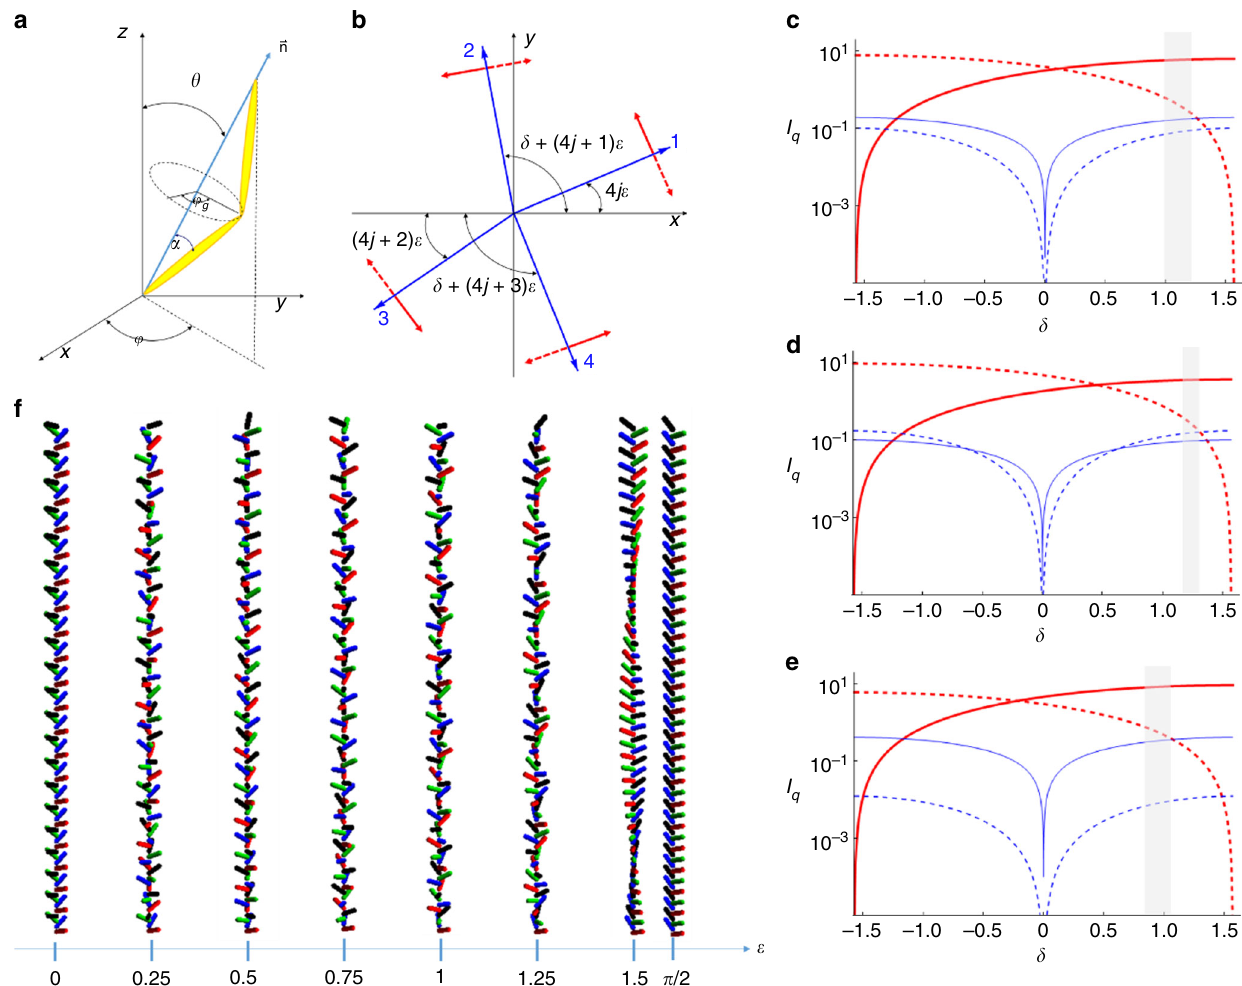
* ) in the laboratory frame is described by the tilt Fig. 3 The double-helical structure in material D1 . a The orientation of the long molecular axis (director n * ´ ^ angle θ and the azimuthal angle φ . The molecular apex angle is π – 2| α |, its direction with respect to the tilt plane normal ( n z ; ^ z being the layer normal), is marked by the angle φ g , which is zero for a molecular tip perpendicular to the tilt plane. Two opposite layer chiralities, with a molecular apex being parallel * ´ ^ * or antiparallel to n z , might be expressed by the opposite signs of angle α . b Projections of n on the smectic plane in the j th stack of four successive layers. On the “ basic ” four-layer structure (with δ ~ π /2), an additional rotation by an angle ε is superimposed. The signs of δ and ε de fi ne the helicity of the four-layer structure and the helical structure superimposed on it, respectively. Red arrows indicate the direction of the molecular apex in the consecutive layers, solid or dashed arrows represent two possible structures with positive or negative α . c − e The intensities ( I q ) of the scattered light as a function of δ at θ = 0.25 and ε = 0.5 for the peaks at q = q 4 + q m (red solid line: πσ - or σπ -polarizations), q 4 − q m (red dashed line: πσ - or σπ -polarizations), q 2 + 2 q m (solid blue line: σσ -polarizations), and q 2 − 2 q m (dashed blue line: σσ -polarizations) for c α = 0 (rod-like molecule), d α = 0.1, and e α = − 0.1. There is a contribution to the q 2 ± 2 q m peak intensities also from the ππ - , πσ - , or σπ -polarizations, but they are orders of magnitude lower than the σσ contribution. The gray-shaded region shows the values of δ at which the ratio between the intensities of the q 4 + q m and q 4 − q m peaks is larger than 10, and at the same time, both intensities are higher than the intensities of the q 2 ± 2 q m peaks. f Temperature evolution of the four-layer structure of the smectic phase induced by increasing ε at constant δ = 1.2 and θ = π /3. The cone angle θ is enlarged to better visualize the rotation of the